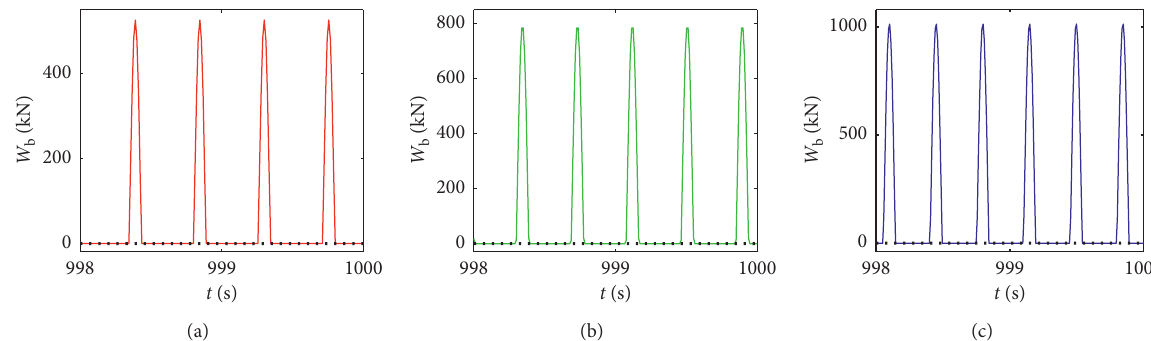
Figure 12: Drilling pressure diagram in the case of bit bounce phenomenon, k (b) phase diagram of torsional